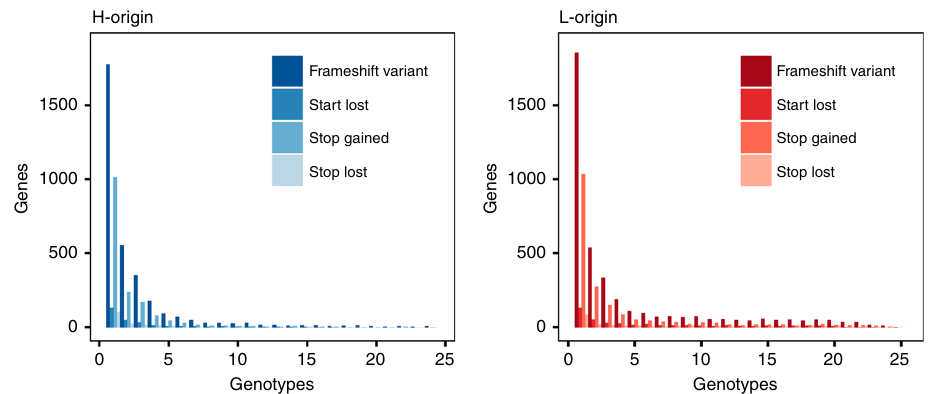
Fig. 5 Frequency distributions of high-impact mutations. The majority of large-effect mutations are at low frequency for both subgenomes. The x axis is the number of genotypes in our resequencing collection (25) and the y axis is the frequency of genes in each of the four categories of